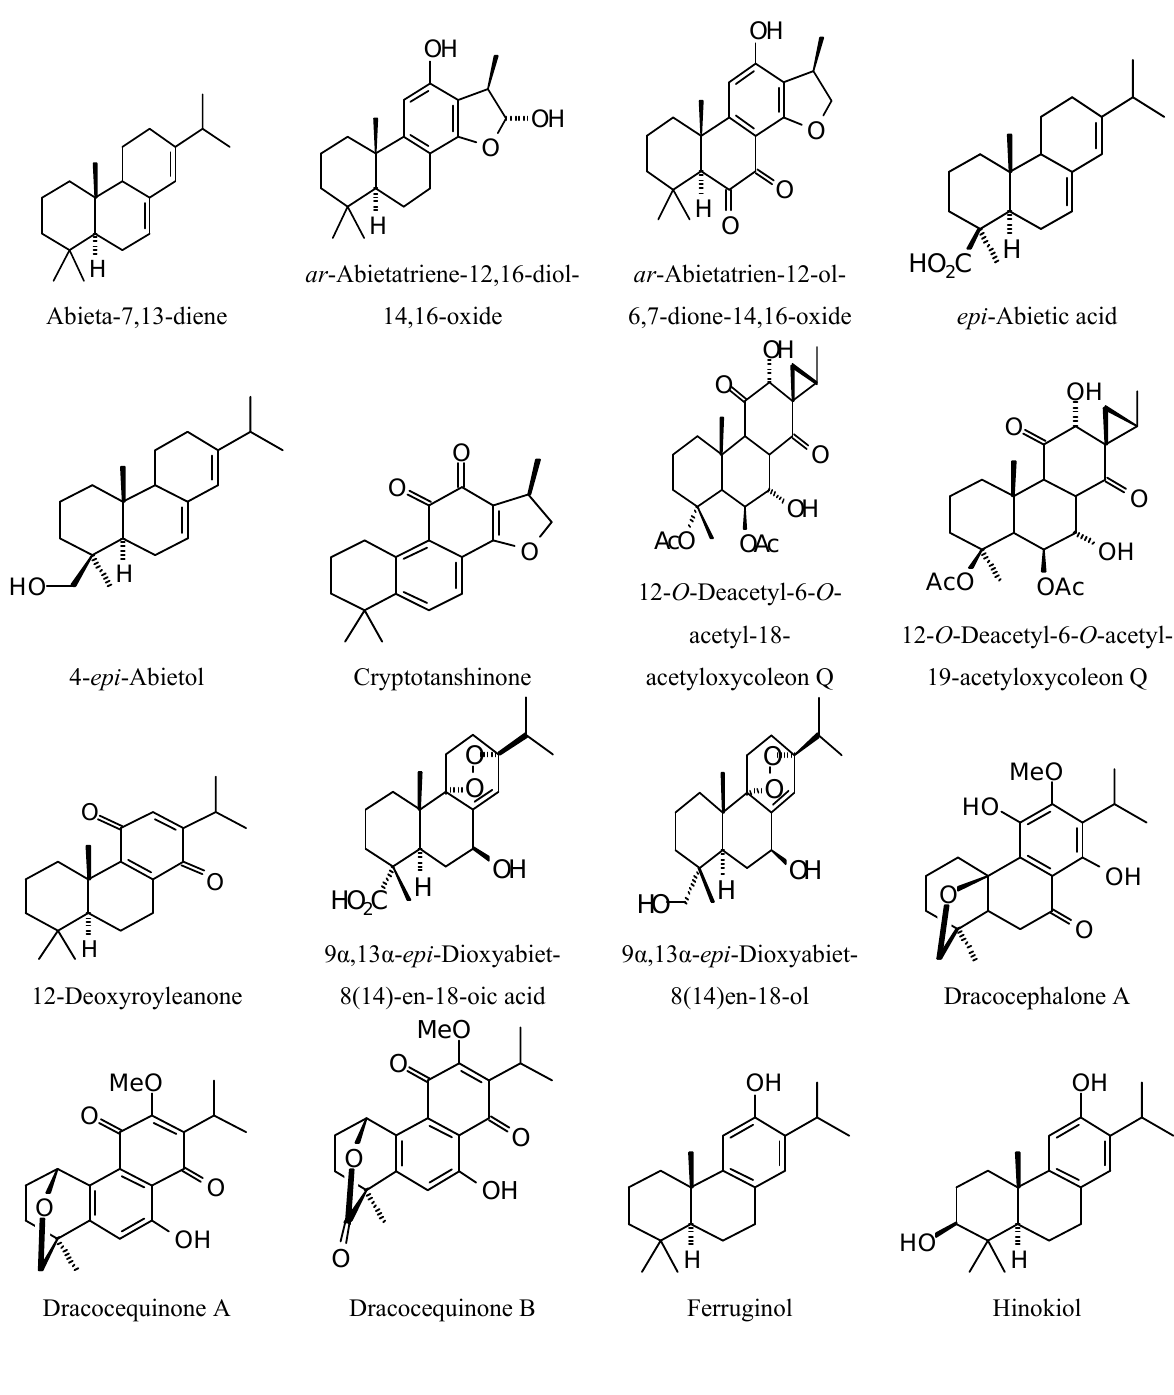
Figure 10. Abietane diterpenoids examined in this